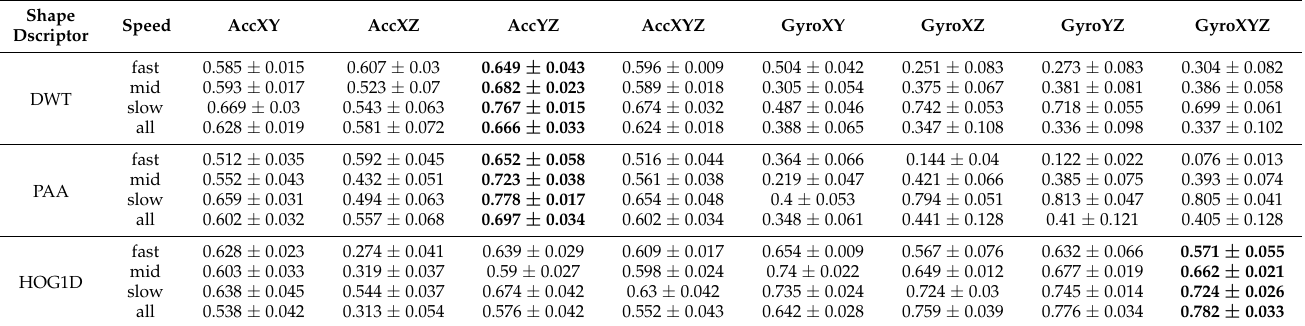
Table 5. Stride segmentation results of different sensor axis combination schemes in F-measure values. Best results for each speed group are highlighted in bold